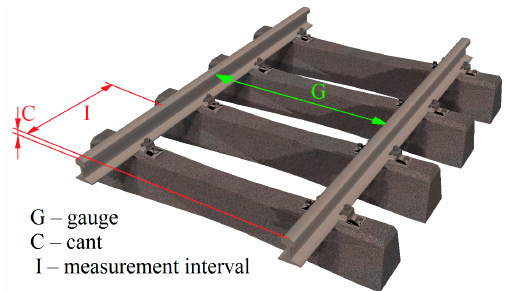
Figure 1. Graphic definition of the Cant (C), Gauge (G), and measurement interval (I).